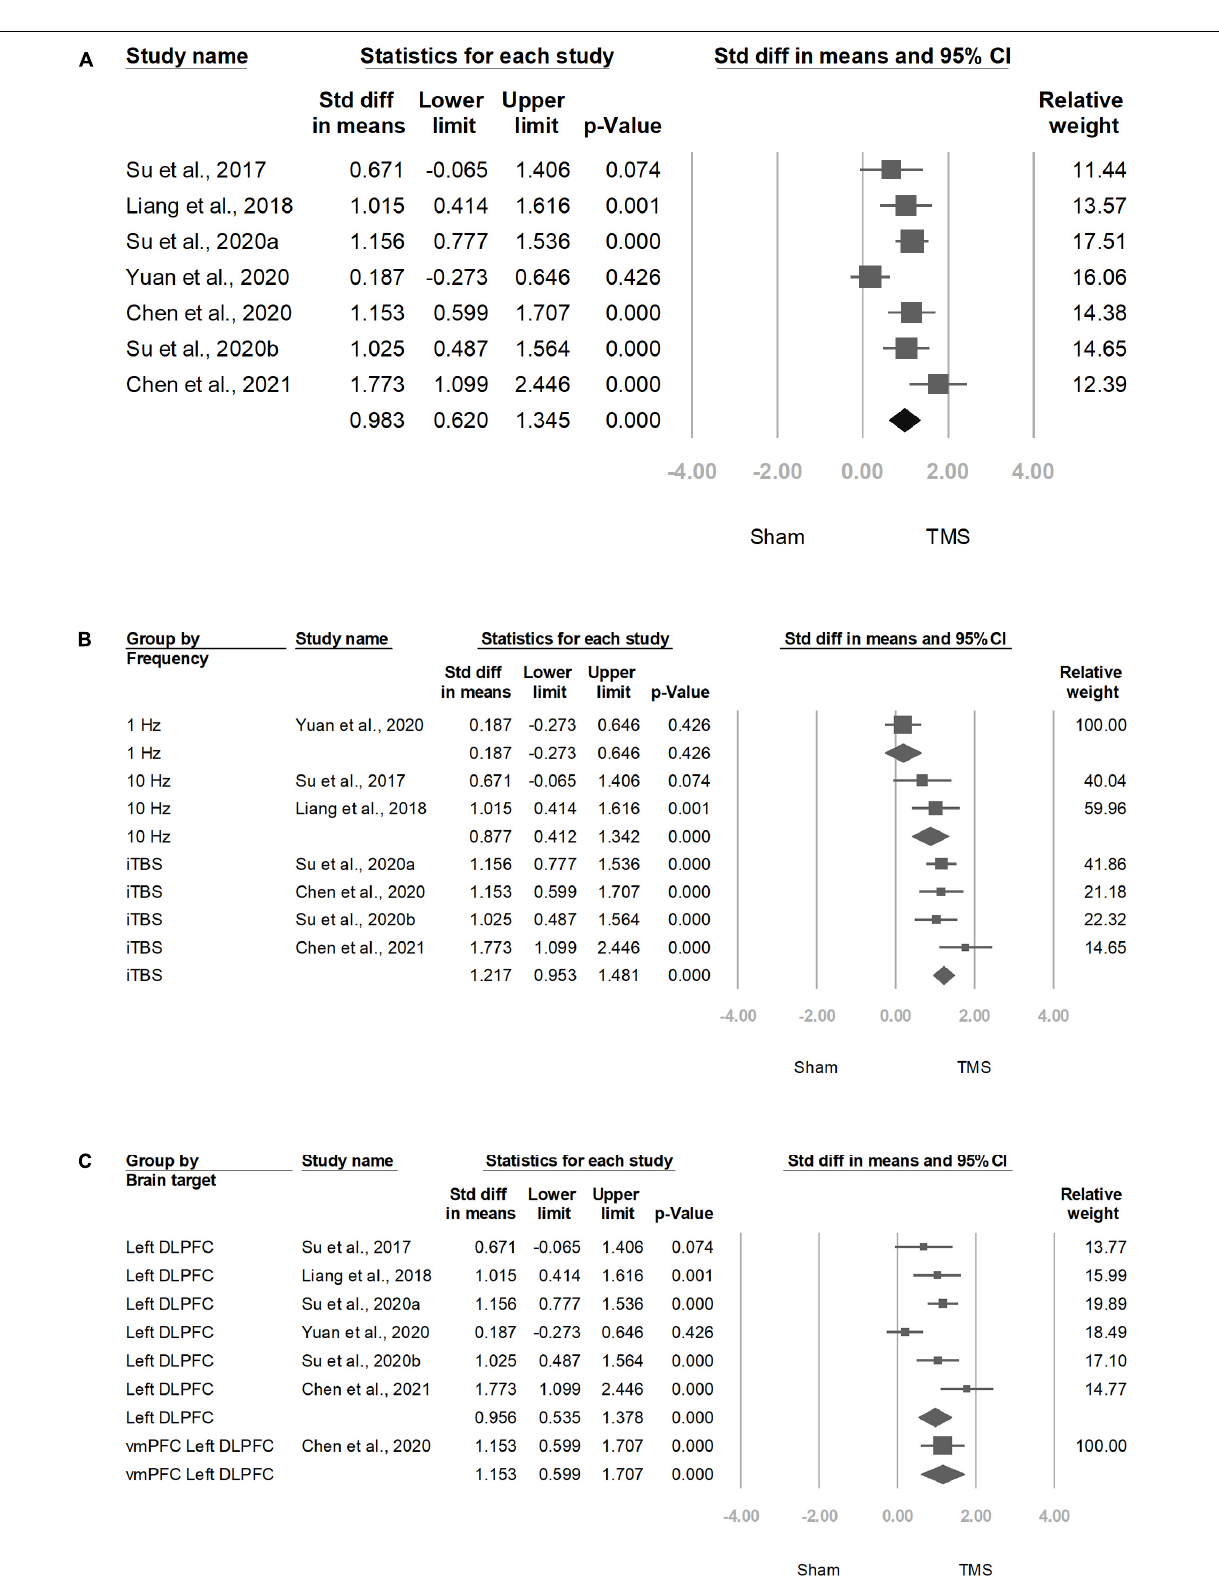
Frontiers in Psychiatry |